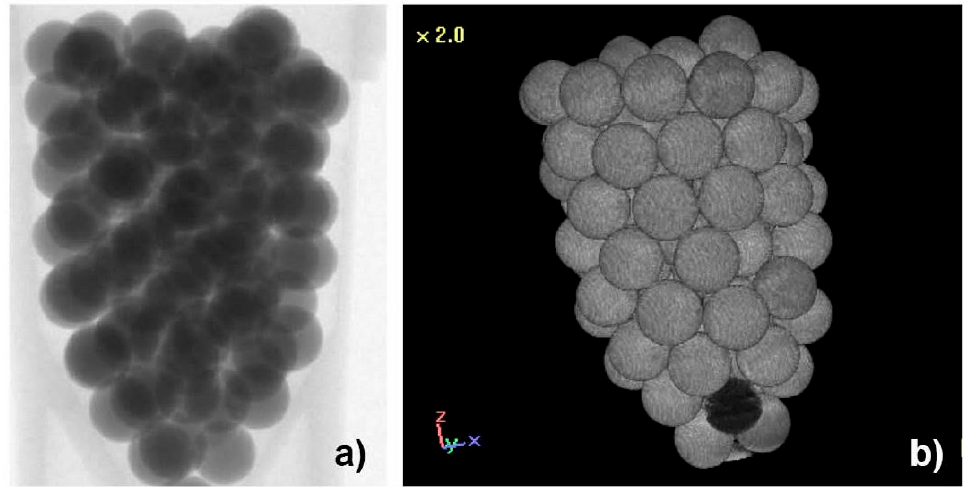
Figure 2. ( a ) X-ray-microtomography scan of ink filler pens; ( b ) 3D view: the dark sphere is made of plastic, all the others of glass.